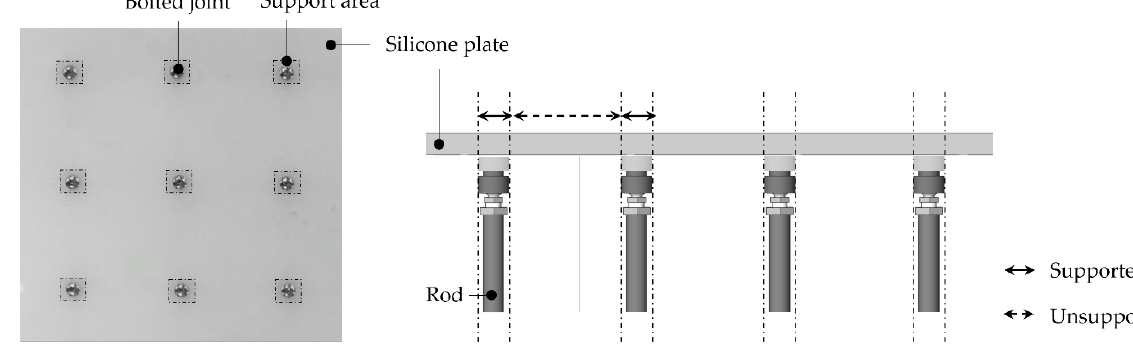
Figure 4. Limitations of bearing the load of concrete.